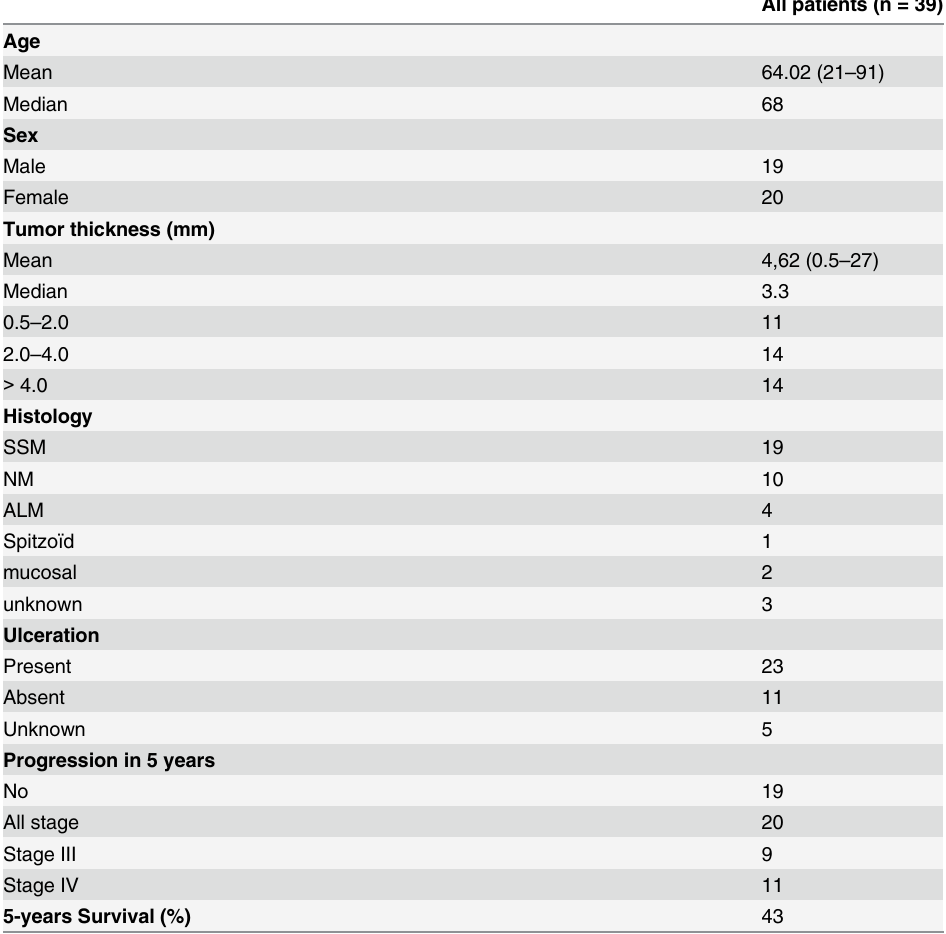
Table 1. Characteristics of the cutaneous melanoma and the clinical evolution of patients included in the studies of primary melanomas. SSM: Superficial Spreading Melanoma; NM: Nodular Melanoma; ALM: Acral Lentiginous